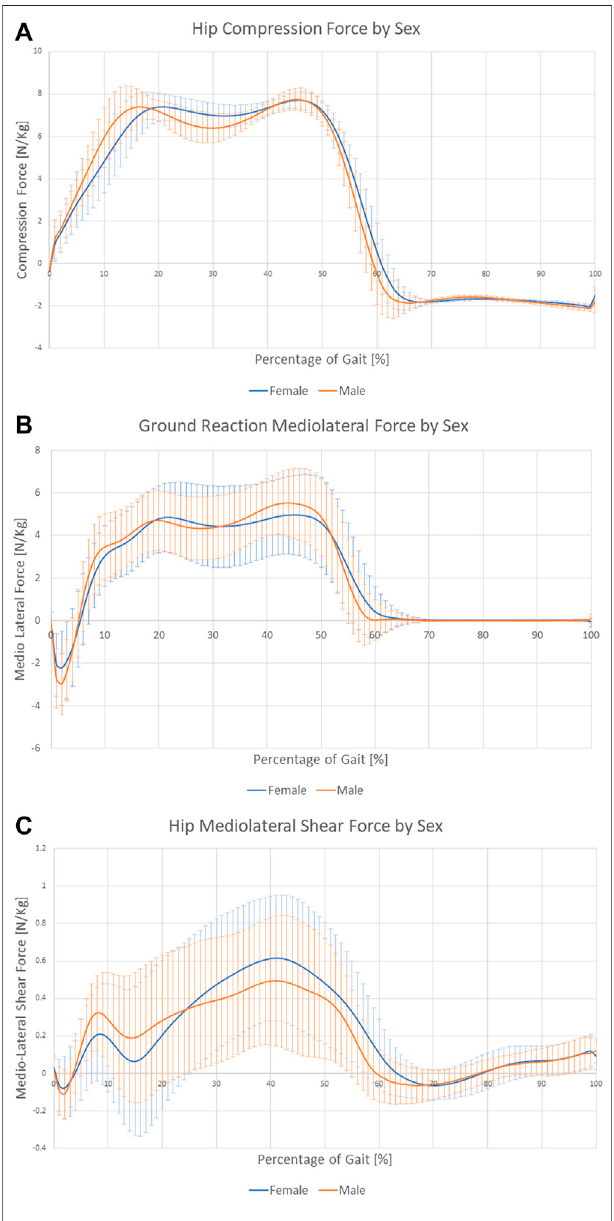
FIGURE 3 | Forces compared between the two sexes: (A) hip compression force pro fi le, (B) ground reaction mediolateral force, and (C) hip mediolateral shear